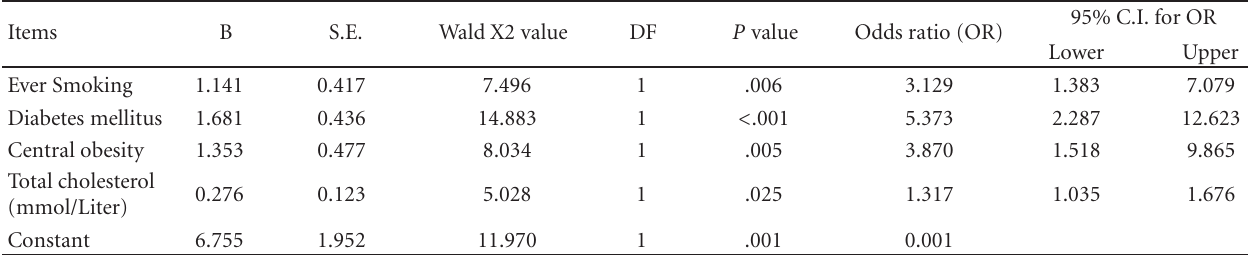
Table 3: Logistic regression analysis of hypertension contributing factors.